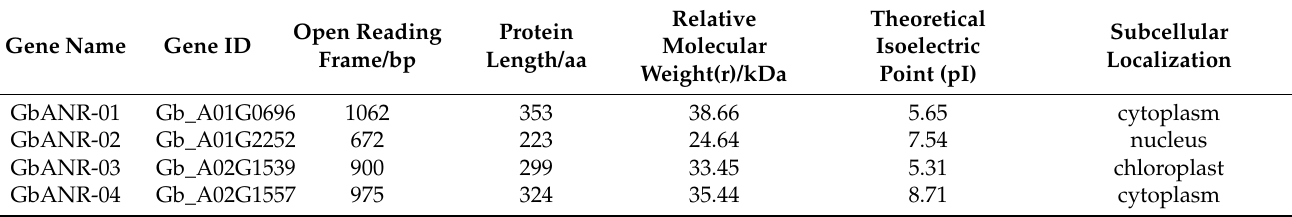
Table 1. Information on the cotton ANR gene family